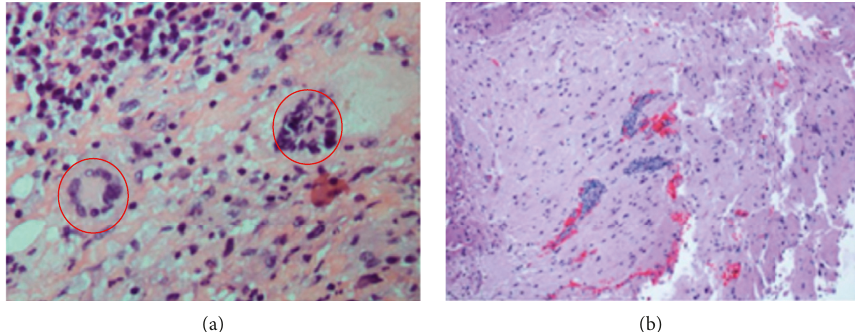
Figure 3: (a) Chronic leptomeningitis with giant cells. (b) Chronic leptomeningitis is demonstrated again; in this cut, parenchymal perivascular lymphocytic infiltrates are